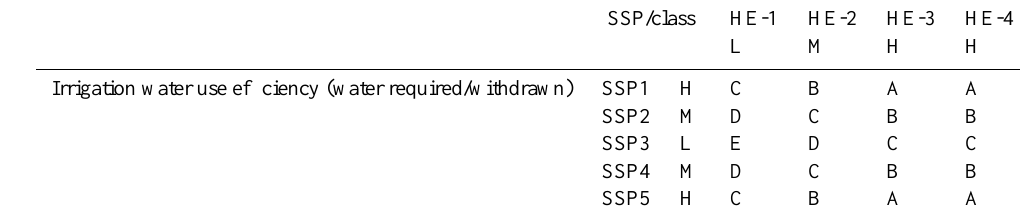
Table A14. Water dimension – irrigation water use efficiency rating.